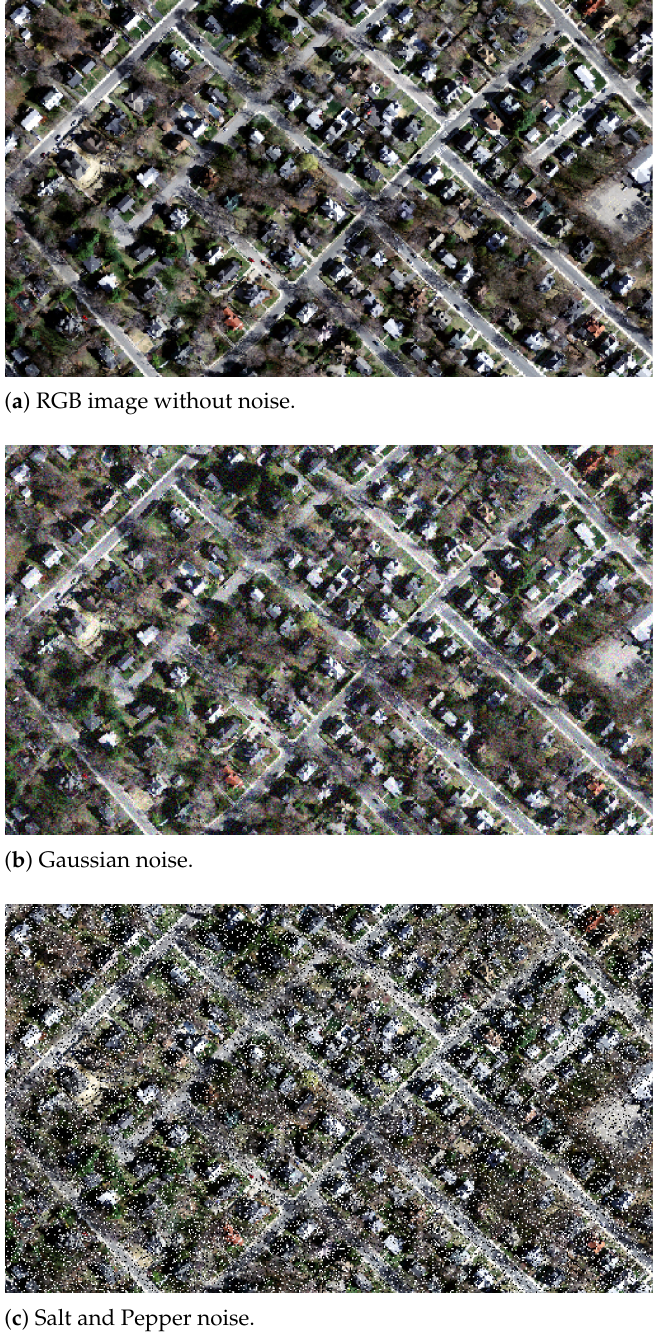
Figure 3. Illustrations of noise added to the test